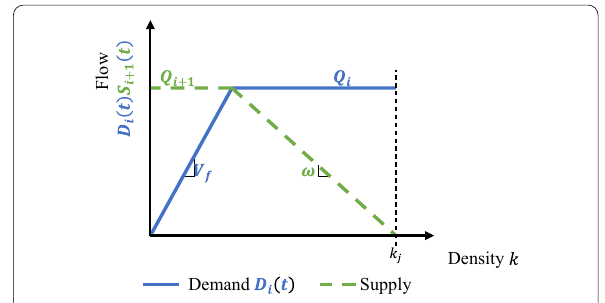
Fig. 1 Trapezoidal fundamental diagram—link